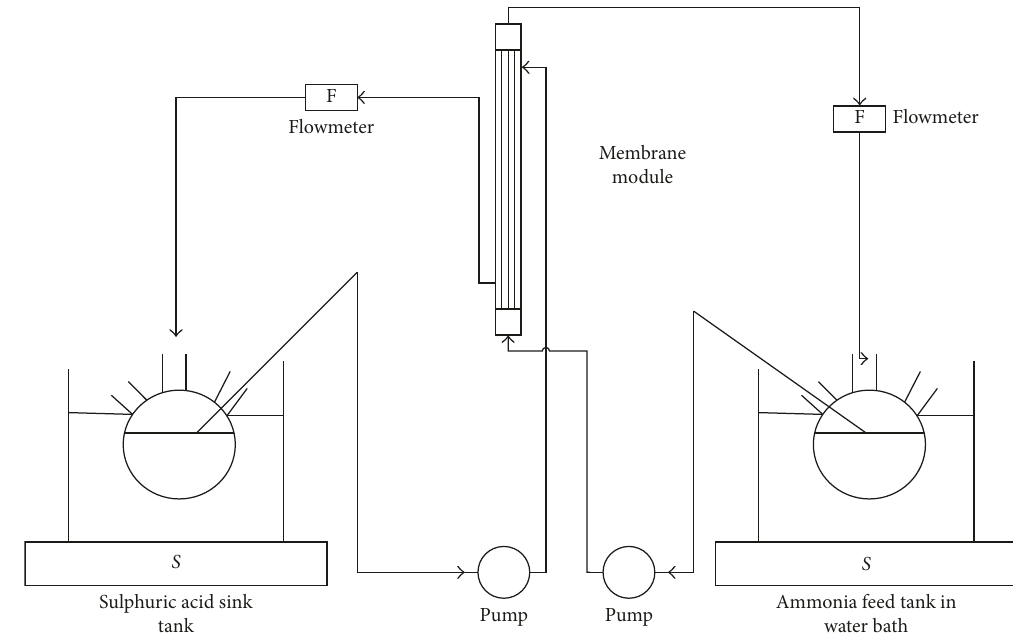
Figure 7: Membrane contactor configuration for ammonia stripping